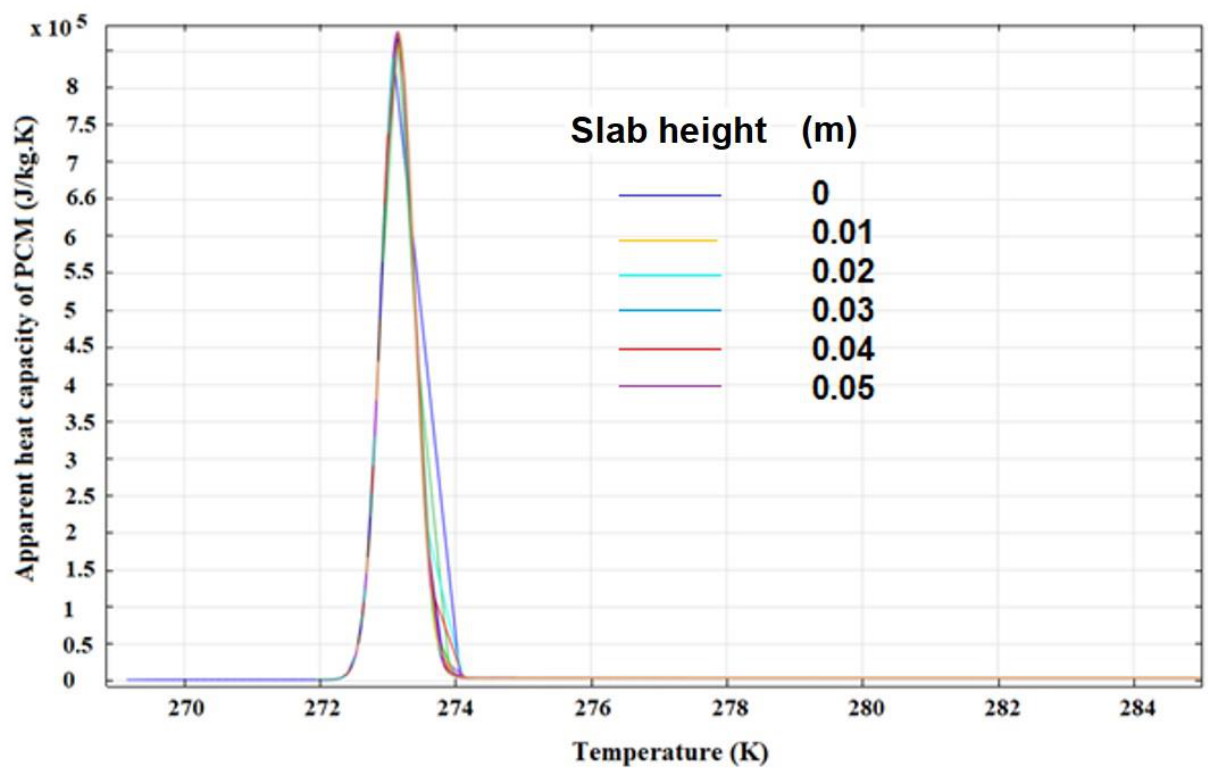
temperature at different times and locations along the slab height are further depicted in Figure 8. The phase change is modeled to take place over a mushy region, i.e., narrow temperature interval, rather than a sharp melting point. The plot shows a good coinci- dence of the heat capacity profile and its peak at different times and locations.